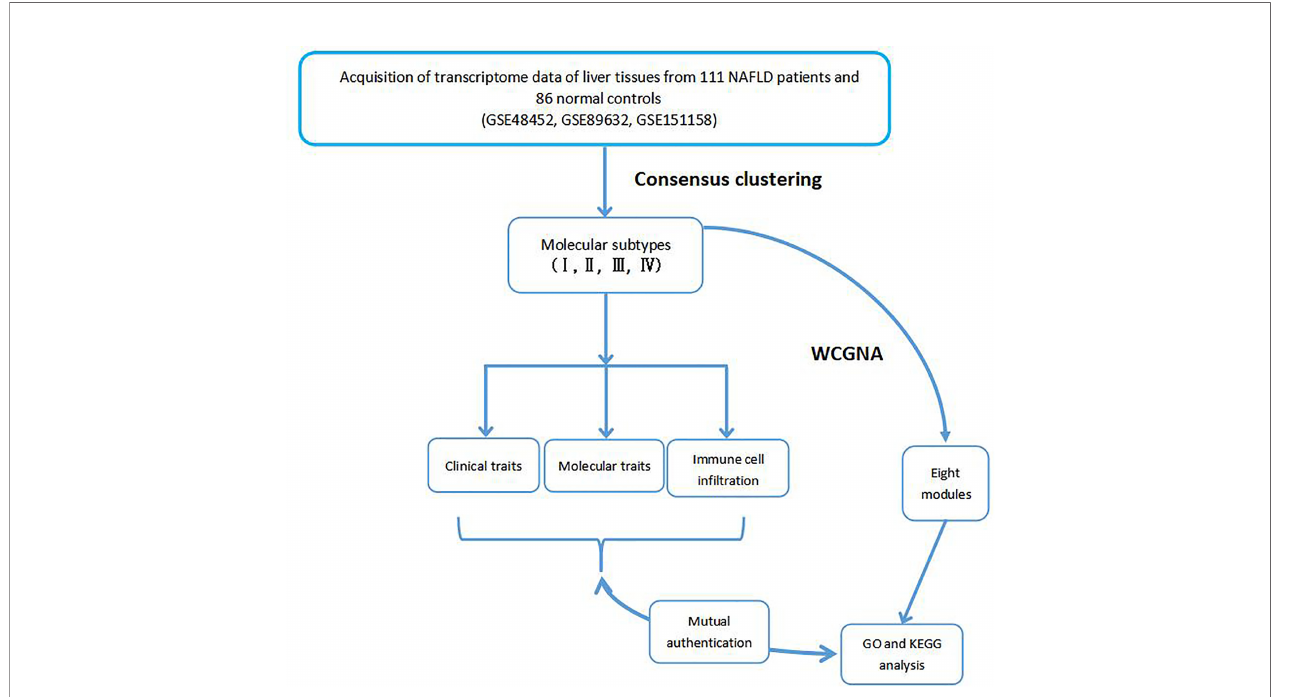
FIGURE 1 | Flowchart of the integrated